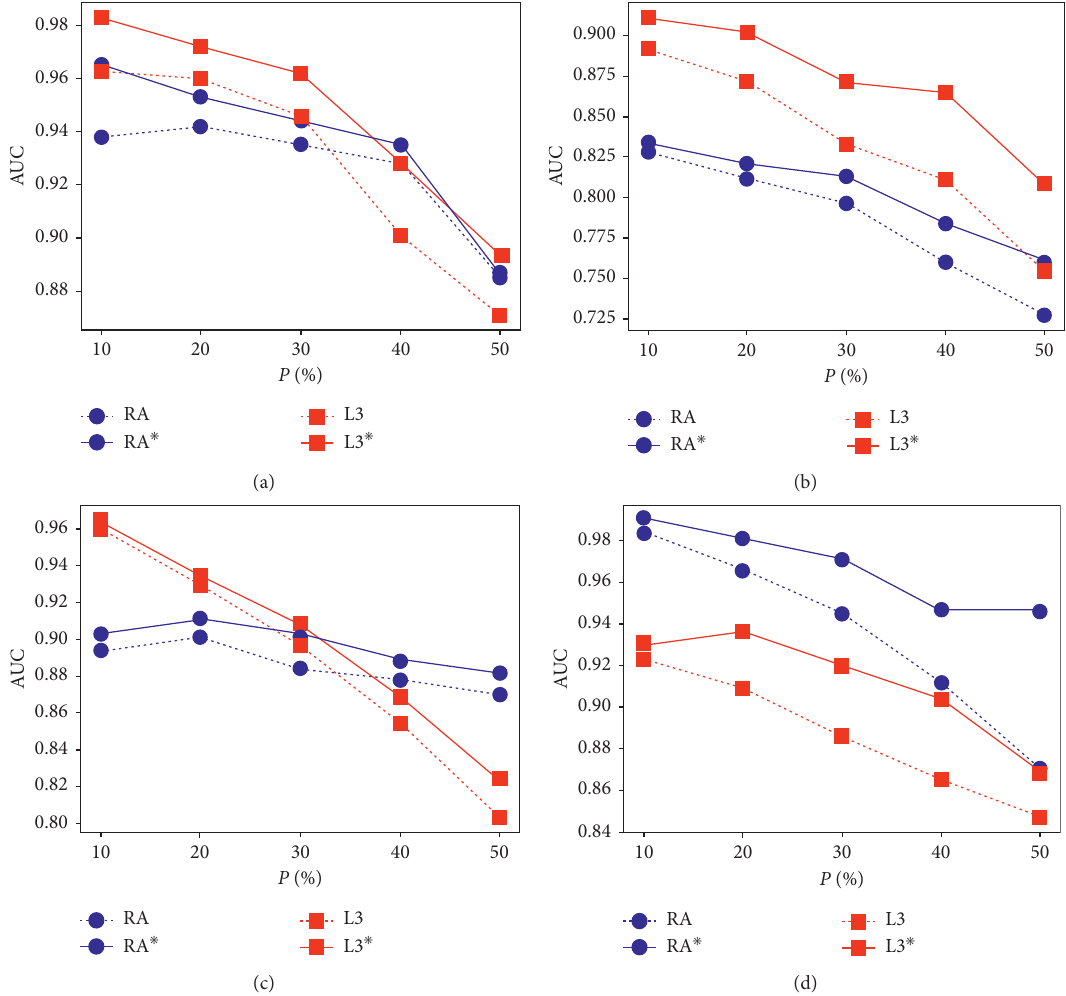
Figure 3: AUC result of four networks. The horizontal axis represents the proportion of the test set to the number of network edges, whereas the vertical axis denotes the AUC value. The blue dotted line represents the AUC of RA, and the blue solid line represents the AUC of RA ∗ . The red dotted line represents the AUC of L3, and the red solid line represents the AUC of L3 ∗ . (a) Lesmis. (b) Polbooks. (c) Metabolic. (d)